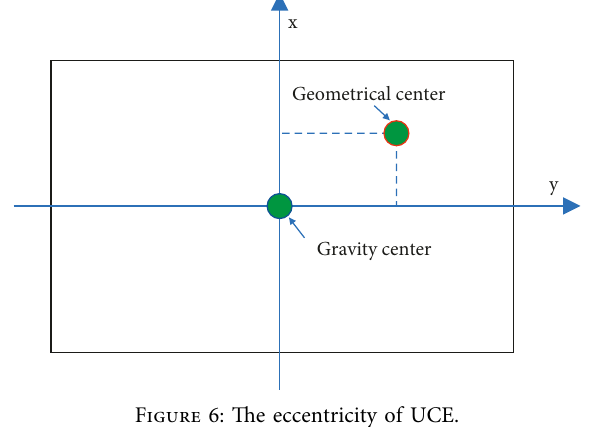
Figure 6: The eccentricity of